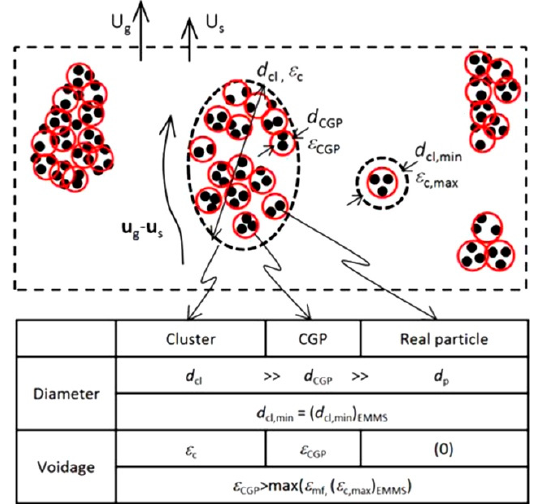
Figure 3. Definition of porous coarse grains in the Energy-Minimization Multi-Scale (EMMS)-DPM model. Reprinted from Reference [16], with permission from Elsevier.